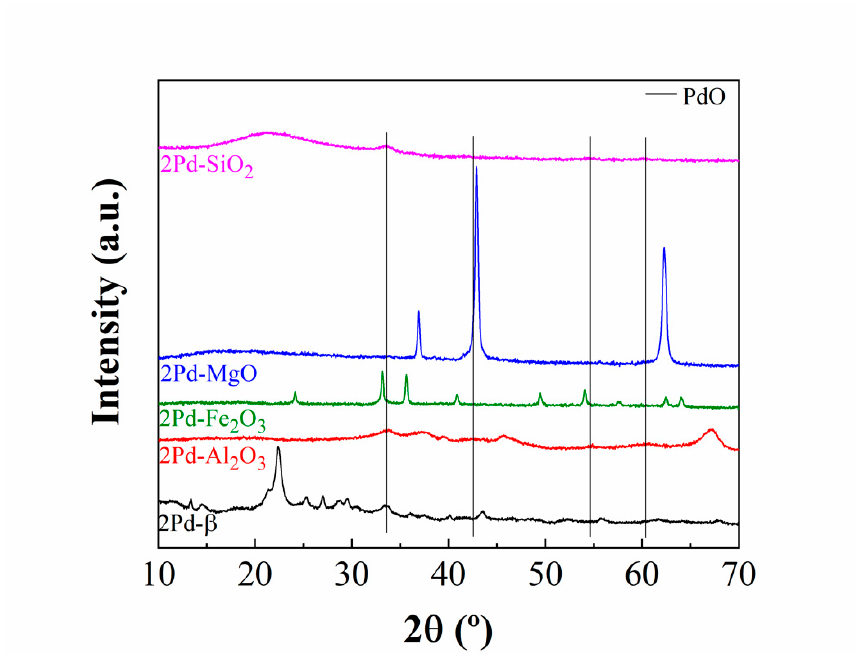
Figure 1. X-ray diffraction patterns of Pd supported on β -zeolite, Al 2 O 3 , Fe 2 O 3 , MgO, and SiO 2 (Pd content: 2 wt.%; vertical lines indicate the position of PdO signals).